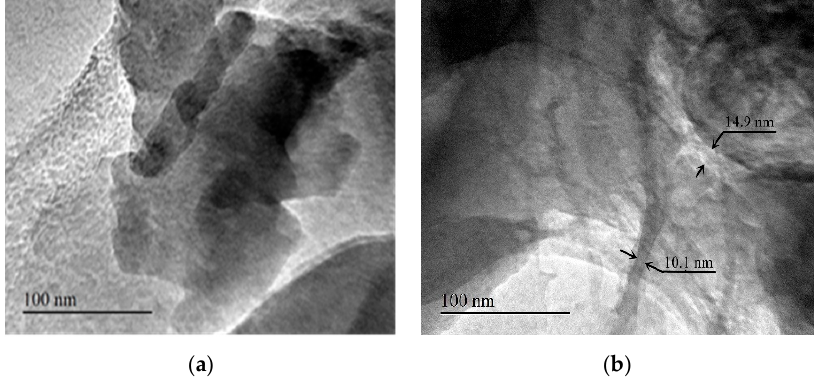
Figure 4. Transmission Electron Microscopy (TEM) images of: ( a ) purified MT; and ( b ) LMT.